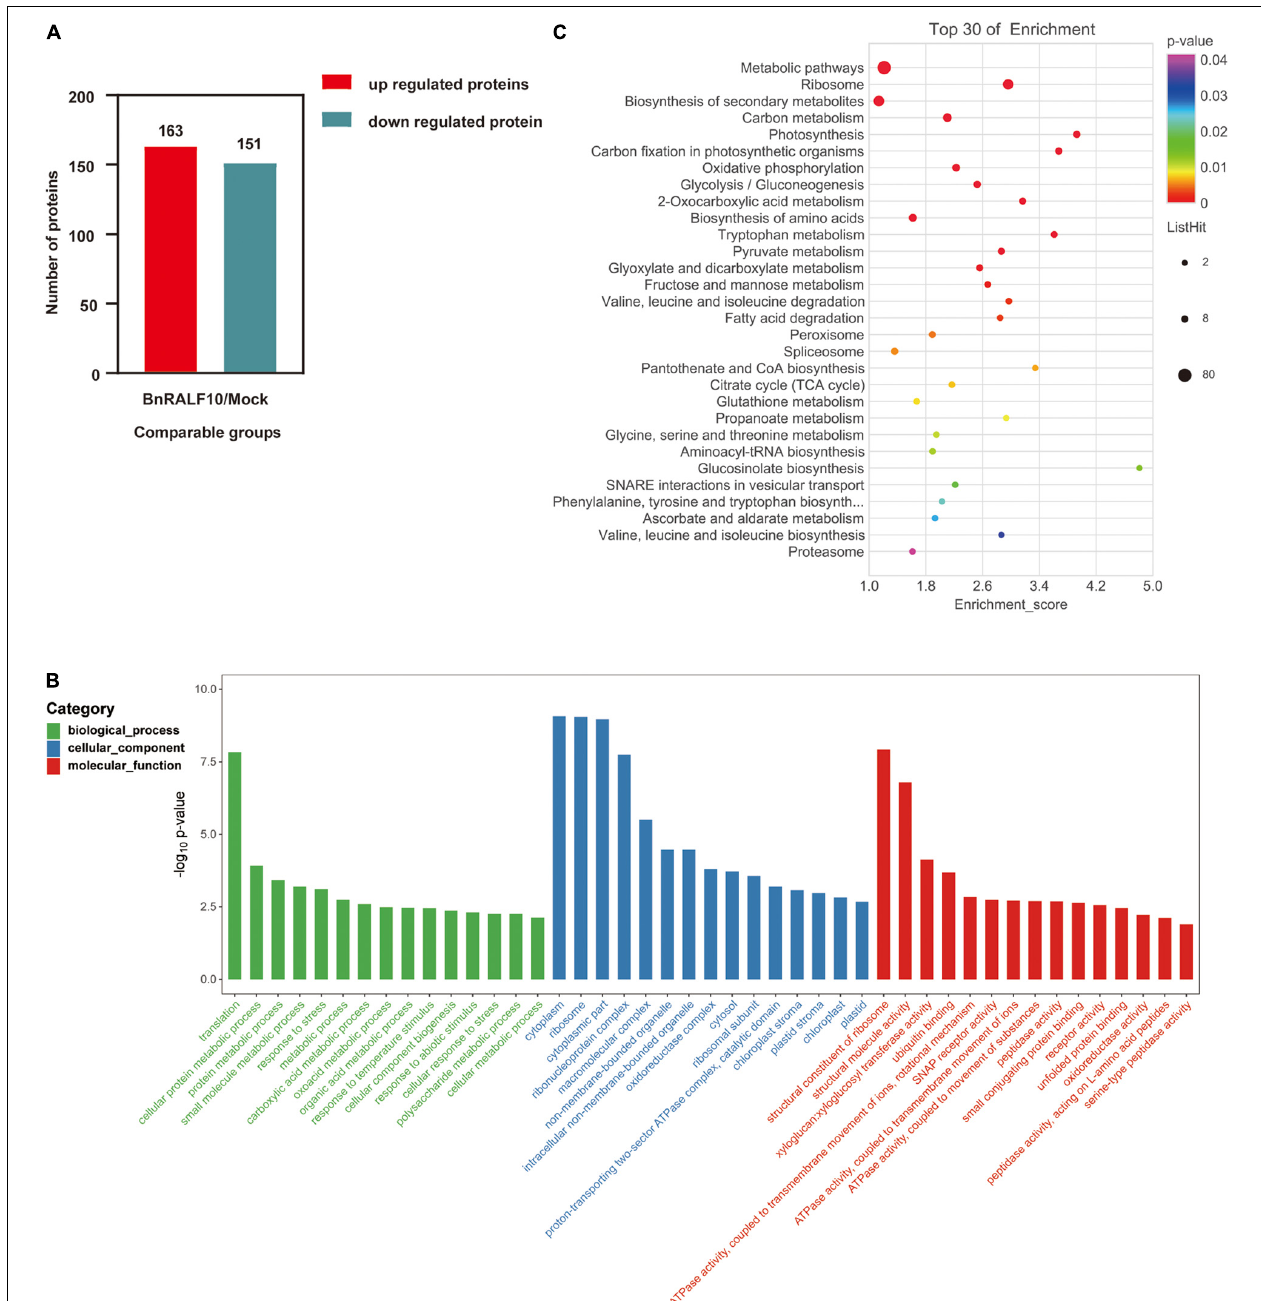
FIGURE 9 | Functional categorization of proteins differentially expressed between oilseed rape leaves infiltrated with 1 µ M BnRALF10 and ddH 2 O. The expression trend (A) , GO and KEGG analyses of differentially expressed proteins (B,C) ( p < 0.05 and fold change > 2 or < 2) were presented. Leaves of 4-week-old oilseed rape plants were sampled at 4 h after infiltration with ddH 2 O and 1 µ M BnRALF10, respectively. The bubble size represents the number of proteins, and the bubble color means the p -value of the significance. The pathway enrichment statistical analysis was performed by Fisher’s exact test. Thirty pathways showing the lowest p -value were selected for this